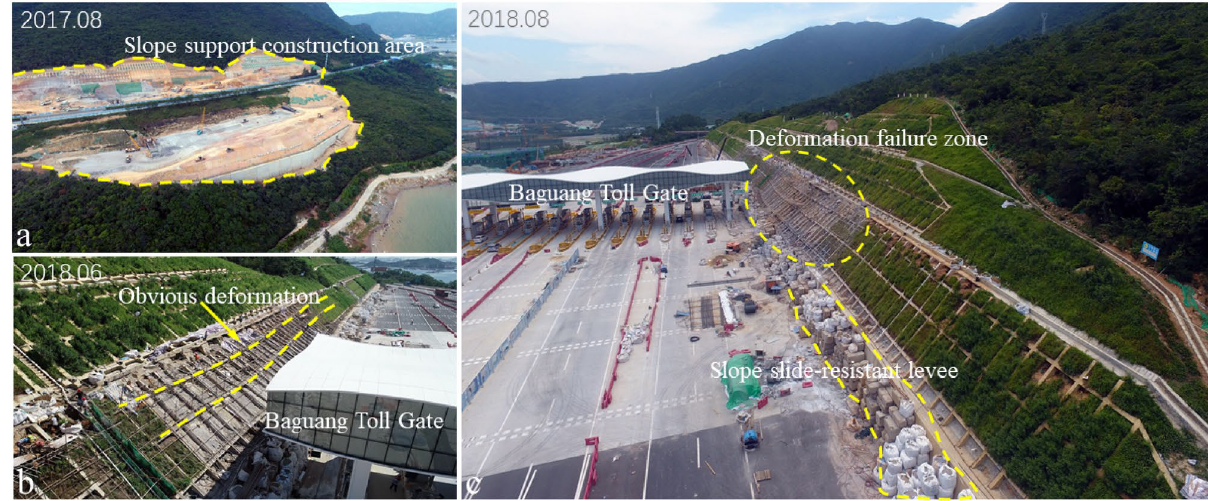
Figure 2. Typical stages before the formation of the Baguang Toll Landslide: ( a ) excavation of the Baguang toll station slope in the initial construction stage; ( b ) large deformation threatening the toll station safety; ( c ) slope supporting structure appears obvious deformation and failure area for suffering